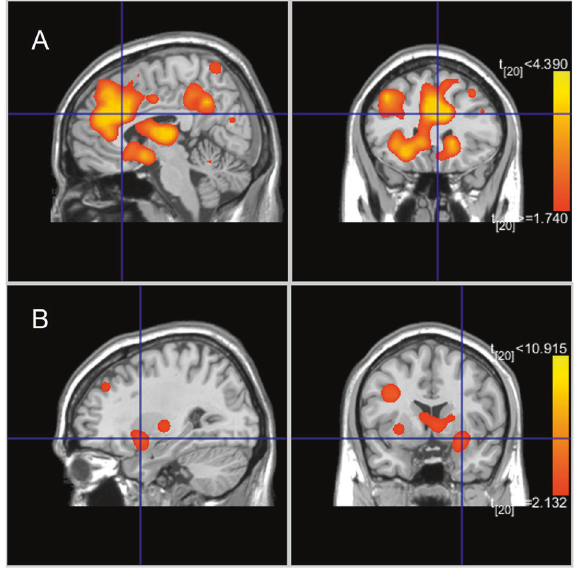
Fig. 4 MKDA fi ndings. Results from the MKDA analyses. A SUD vs controls and ( B ) BA vs